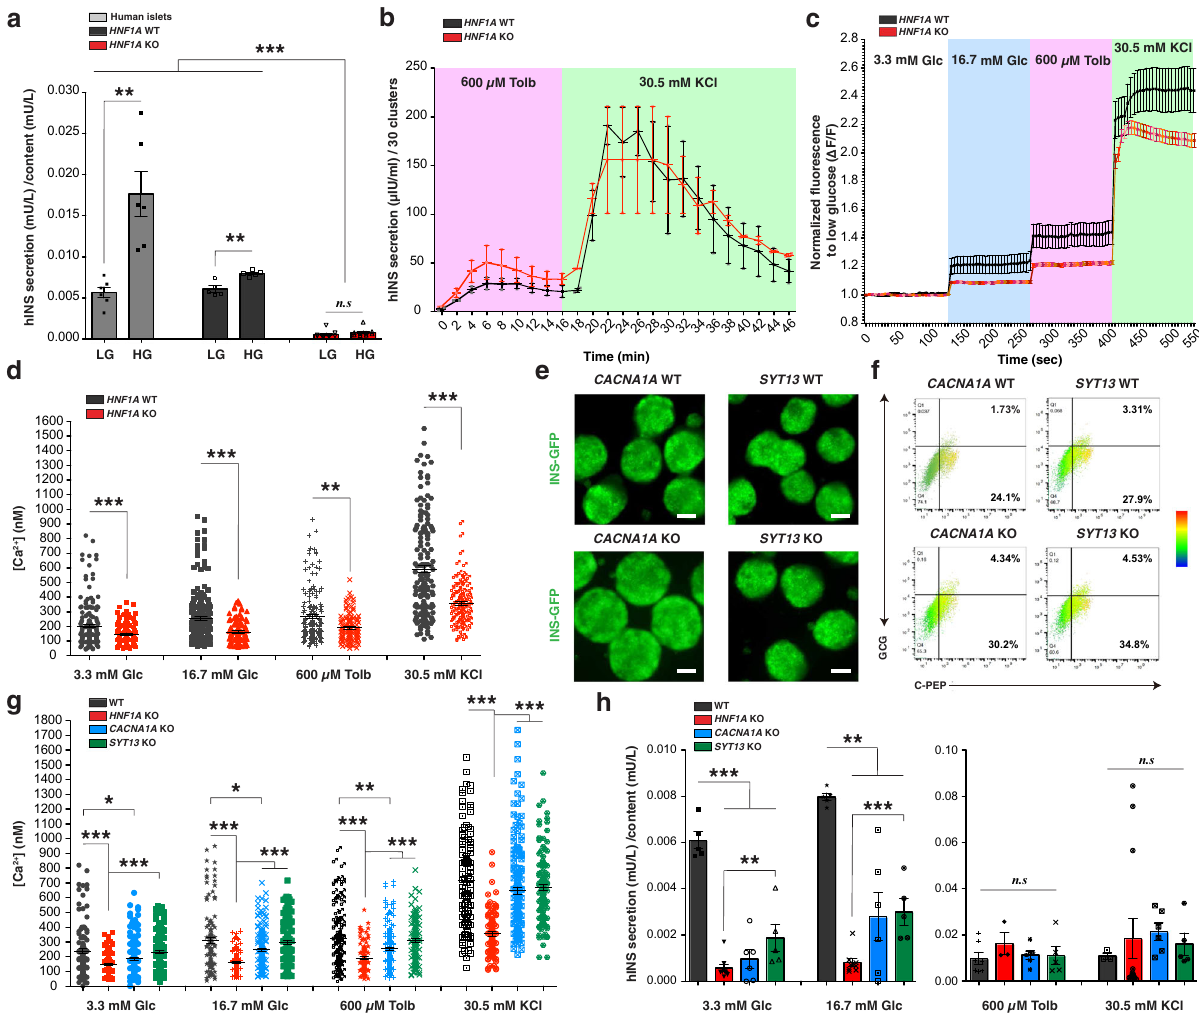
Fig. 3 HNF1A de fi ciency affects insulin secretion due to reduced intracellular calcium levels in association with CACNA1A and SYT13 down-regulation in vitro. a Human insulin secretion (mU/L) in 1 h normalized to content (mU/L) in response to low glucose (LG, 3.3 mM) and high glucose (HG, 16.7 mM) stimulation in the static assay of hESC-derived endocrine cell lines ( HNF1A WT and KO) and pancreatic human islets. b Human insulin secretion ( µ IU/ml) normalized to 30 clusters in a perfusion assay (both HNF1A WT and KO genotypes n = 2) in response to indicated secretagogues. c Intracellular calcium fl uorescence normalized to low glucose (F340/380) from dispersed sc β -like cells with d absolute intracellular calcium concentration (nM) quanti fi cation in response to indicated secretagogues (each point represents an sc β -like-cell, HNF1A WT n = 170 and HNF1A KO n = 110 cells). e Representative GFP- fi eld images of endocrine organoids from indicated genotypes. Scale bars: 200 µ m. f Representative CPEP + and GCG + populations quanti fi cation by fl ow cytometry. g Absolute intracellular calcium concentration (nM) in response to indicated secretagogues (each point represents a sc β -like-cell from independent batches of differentiation, WT n = 110, HNF1A KO n = 110, CACNA1A KO n = 175, and SYT13 KO n = 120 cells). h Human insulin secretion (mU/L) in 1 h normalized to content (mU/L) in response to low (3.3 mM) and high glucose (16.7mM) and indicated secretagogues in static assay (WT n = 5, HNF1A KO n = 9, CACNA1A KO n = 6 and SYT13 KO n = 5). All stem cell differentiation was done for 27 days. 20 clusters ( ∼ 10k cells per cluster) of endocrine cells were used fl ow cytometry. n represents the number of biological replicates. For scatter plots, each point in the plot represents an independent biological experiment ( n ). Data are represented as mean ± SEM. p -values: * p < 0.05, ** p < 0.01, *** p < 0.001; Mann – Whitney test. n.s. non- signi fi cant. See also Fig. S8. However, mice transplanted with hESC HNF1A KO β -cells had plasma was not a limitation of the sensitivity of the assay but a virtually undetectable plasma human insulin concentrations for decrease in the stoichiometry of insulin to C-peptide in circula- 30 weeks (Fig. 4b) despite human C-peptide levels of >300 pM. tion. While plasma of mice grafted with HNF1A WT β -cells These differences in hormone secretion between HNF1A mutant consistently showed an insulin:C-peptide molar ratio of and WT sc β -cells were not due to reduced sc β -cell mass in vivo 0.22 ± 0.11 from week 4 to 30 post-transplantation, mice grafted (Fig. 2i). These fi ndings led us to quantify the secretion ratio of with HNF1A KO β -cells had an 18-fold lower ratio (Fig. 4c). This hormones in sc β -cells in vitro. For equivalent secretion of human decrease in circulating insulin:C-peptide ratio was reciprocal to a C-peptide at basal glucose condition (Fig. S8g), secretion of 3-fold increase in the insulin:C-peptide ratio of intracellular human insulin was signi fi cantly reduced in hESC HNF1A KO content from HNF1A KO isolated grafts (Fig. 4d), indicating a lines (Fig. S8h), leading to decreased insulin:C-peptide secretion complementary imbalance of insulin to C-peptide. The altered ratios in vitro (Fig. S8i). Thus, the absence of insulin in the insulin:C-peptide ratio is not attributable to differences in insulin COMMUNICATIONS BIOLOGY| (2022) 5:779